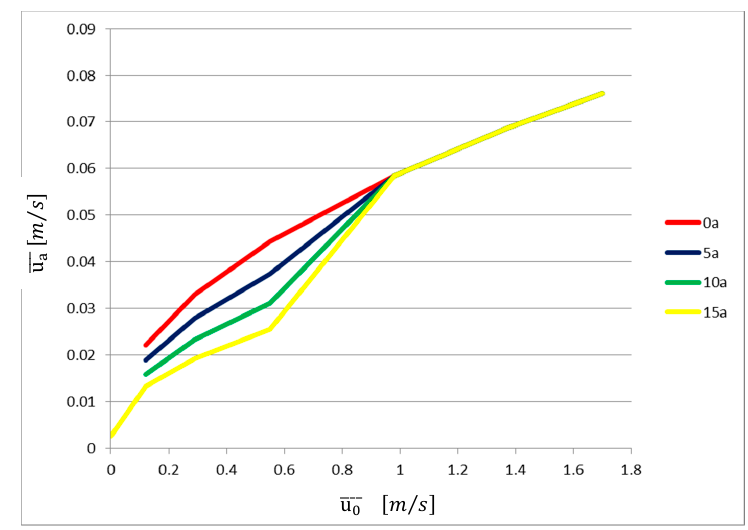
Figure 15. Comparison between experimental results and Equation (23).